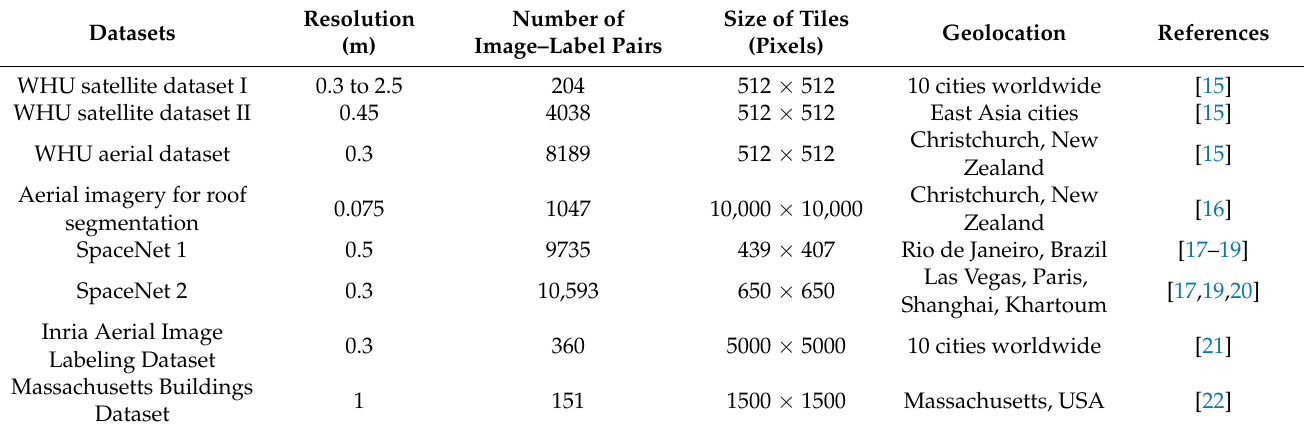
Table 1. Summary of frequently used public datasets in CNN-based building footprint